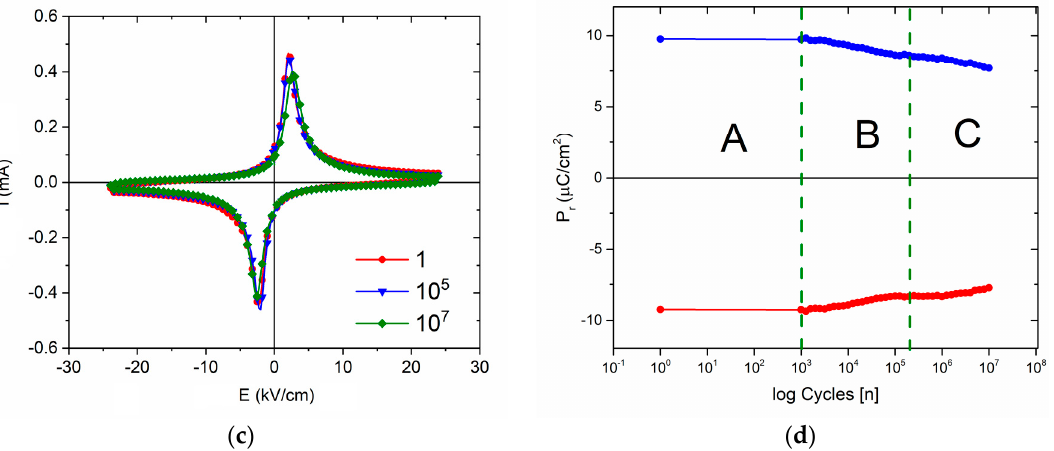
Figure 7. The changes of ( a ) polarization, ( c ) current, and ( d ) remanent polarization of the BCTZ8-5 sample during different fatigue cycling analyses. ( b ) A magnification of the polarization axis with the different obtained P r values at 1, 10 5 , and 10 7 cycles. Table 2. The average of P r , E c , and I at different fatigue cycling processes for BCTZ8-5.